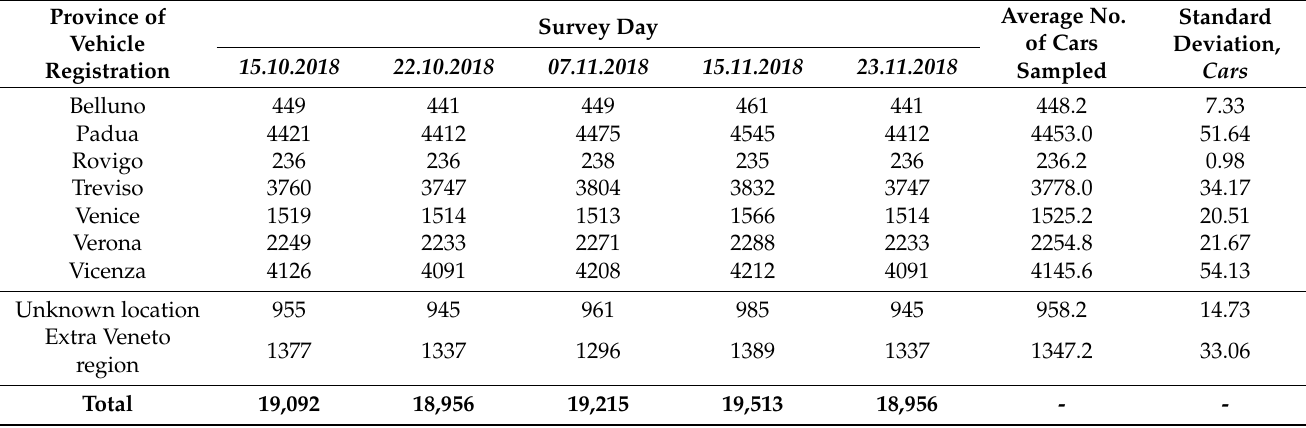
Table 3. Characteristics of sampled